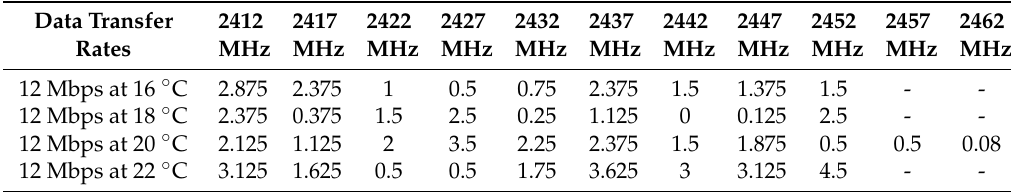
Table 13. Calculation of residuals for OFDM at 12 Mbps.